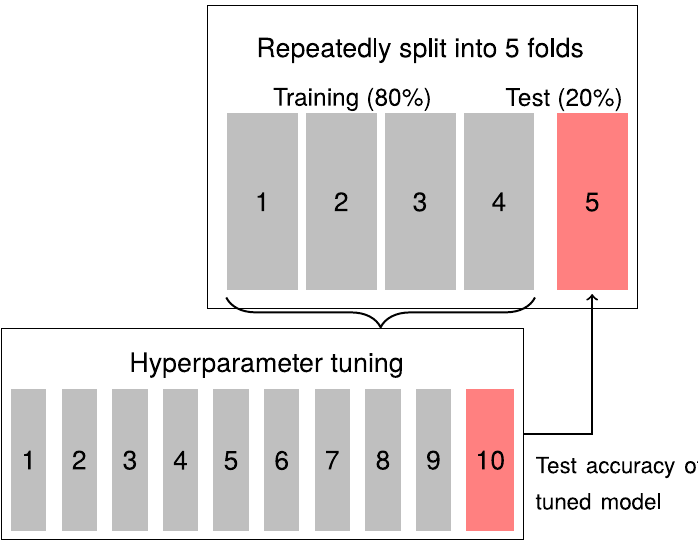
Fig 2. Model training, nested cross-validation (CV). First, the data is split into five parts. Four parts are used for training. For each model a 10-fold CV is run on this training data to find optimal hyperparameters for each algorithm. When training the LASSO, different values for λ (penalty to weakly correlated variables) are tested, for Random Forest the number of randomly selected features to consider at each split changes. In each run the model is trained on 9/10th of the data and tested on the last decile. The best version (with highest AUC) is trained on all of the training data and its accuracy is estimated on the fifth fold of the outer loop. The process is repeated with a different outer fold held out. After five runs, a new set is drawn, and the process is repeated until 100 accuracy metrics have been generated.